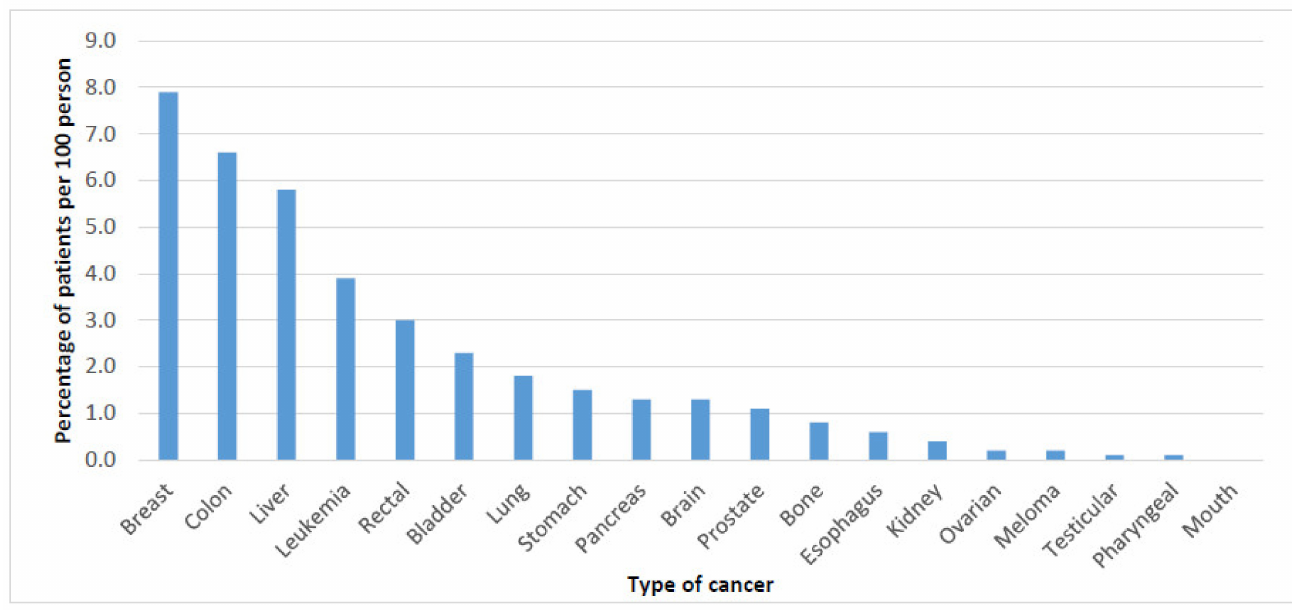
Figure 2. Type of cancer stratified by